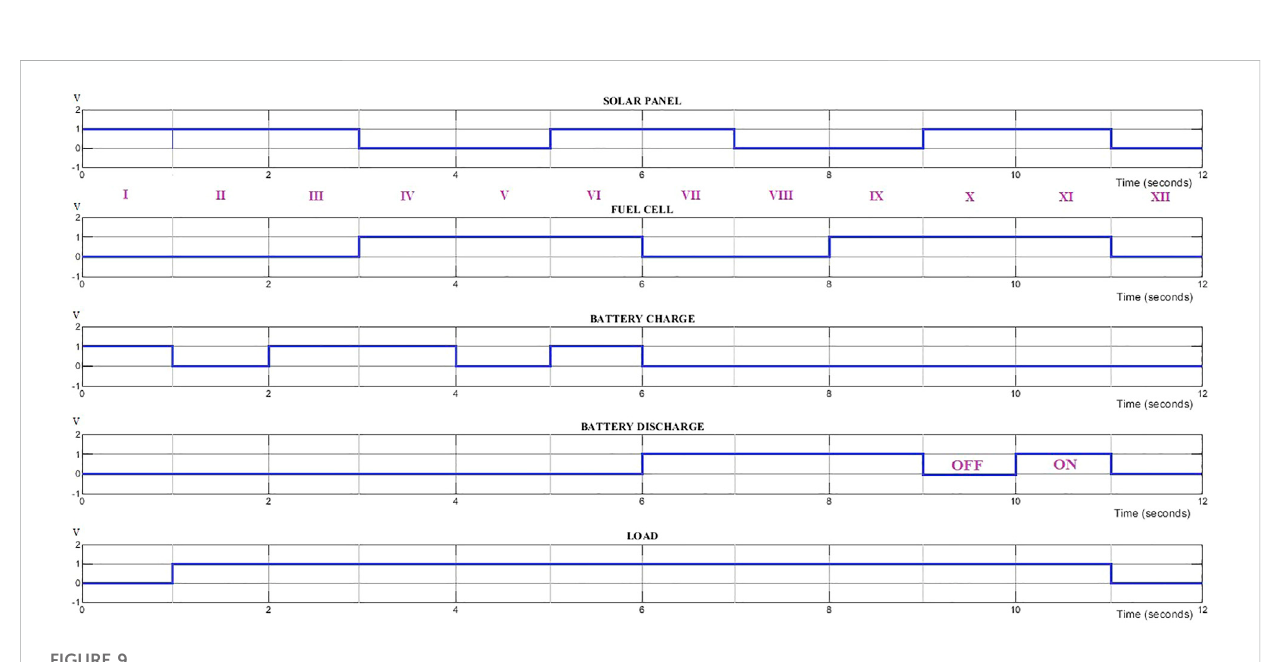
FIGURE 9 Control pulse generation with various possible